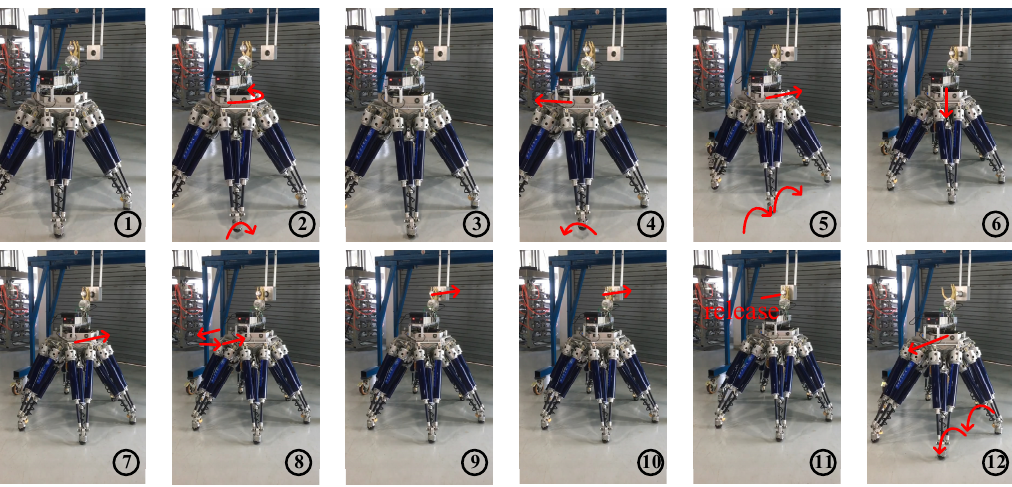
Figure 14. Snapshots of the experiment.